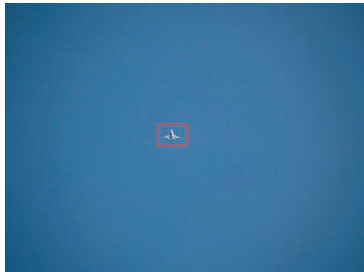
Figure 2. Attention in the human visual system. Although the image primarily involves the background, people are easily able to capture the airplane in the red rectangle.